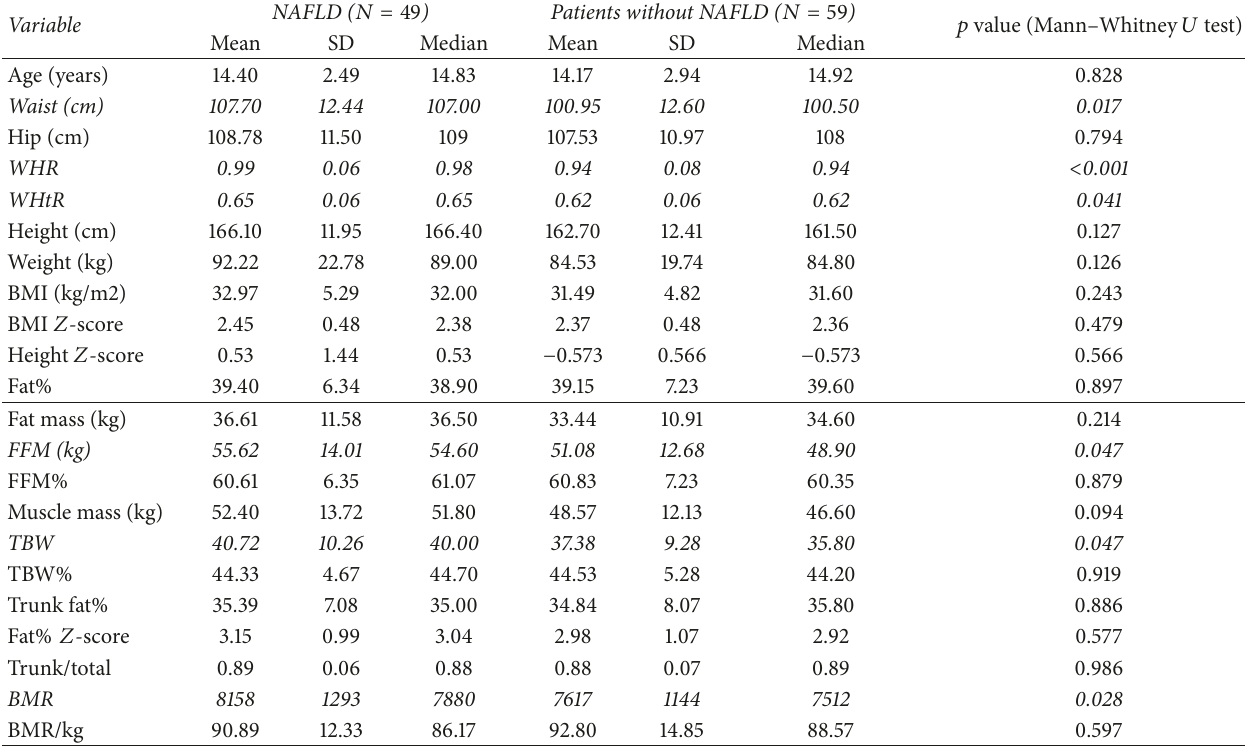
Table 2: Anthropometry and body composition. Comparison of patients with and without NAFLD.